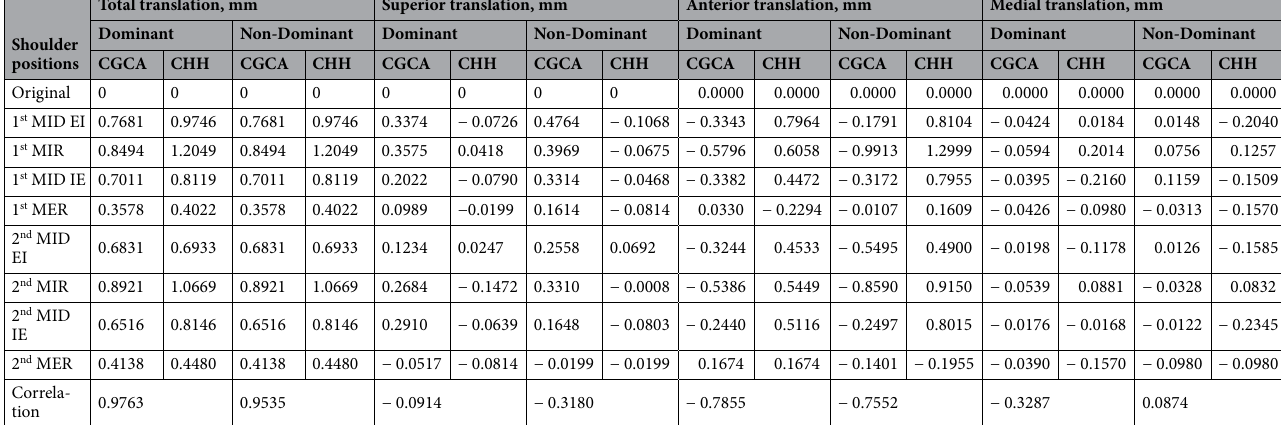
Table 2. Correlation between the Center of Glenohumeral Contact Area and the Center of Humeral Head. CGCA: Center of glenohumeral contact area. CHH: Center of humeral head. MER: Maximum external rotation. MIR: Maximum internal rotation. MID EI: Midpoint from MER to MIR. MID IE: Midpoint from MIR to MER.